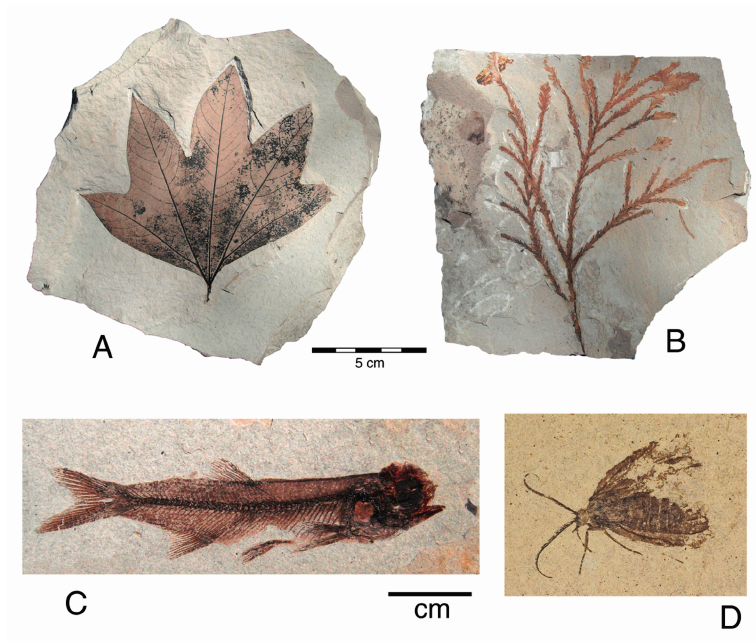
Figure 2. Republic Boot Hill locality fossils: ( A ) Macginitea gracilis (Stonerose Museum SR010003004A); ( B ) Sequoia langsdorfi (SR-02027008A); ( C ) Eohiodon woodruffi (Stone Rose museum, not curated); and ( D ) unidentified moth (University of Washington Burke Museum specimen UWBM 6600B B2757, photographed by T.A.